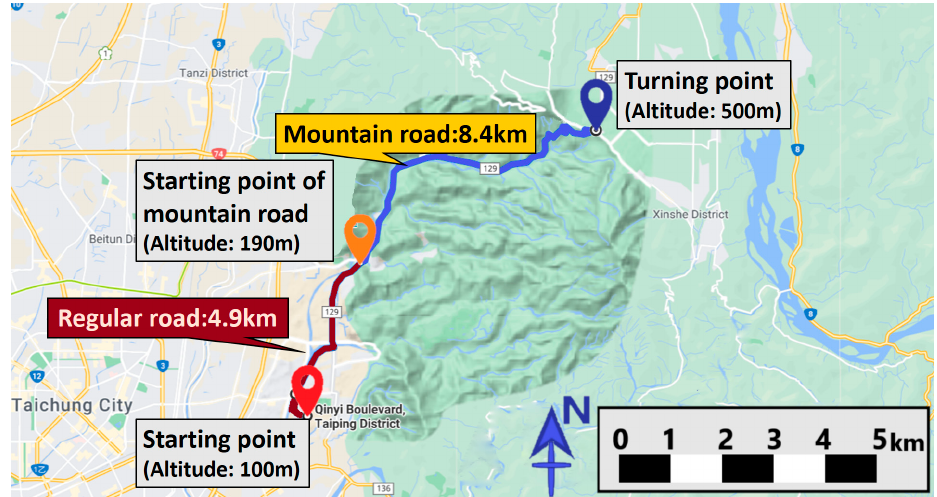
Figure 8. Test route.